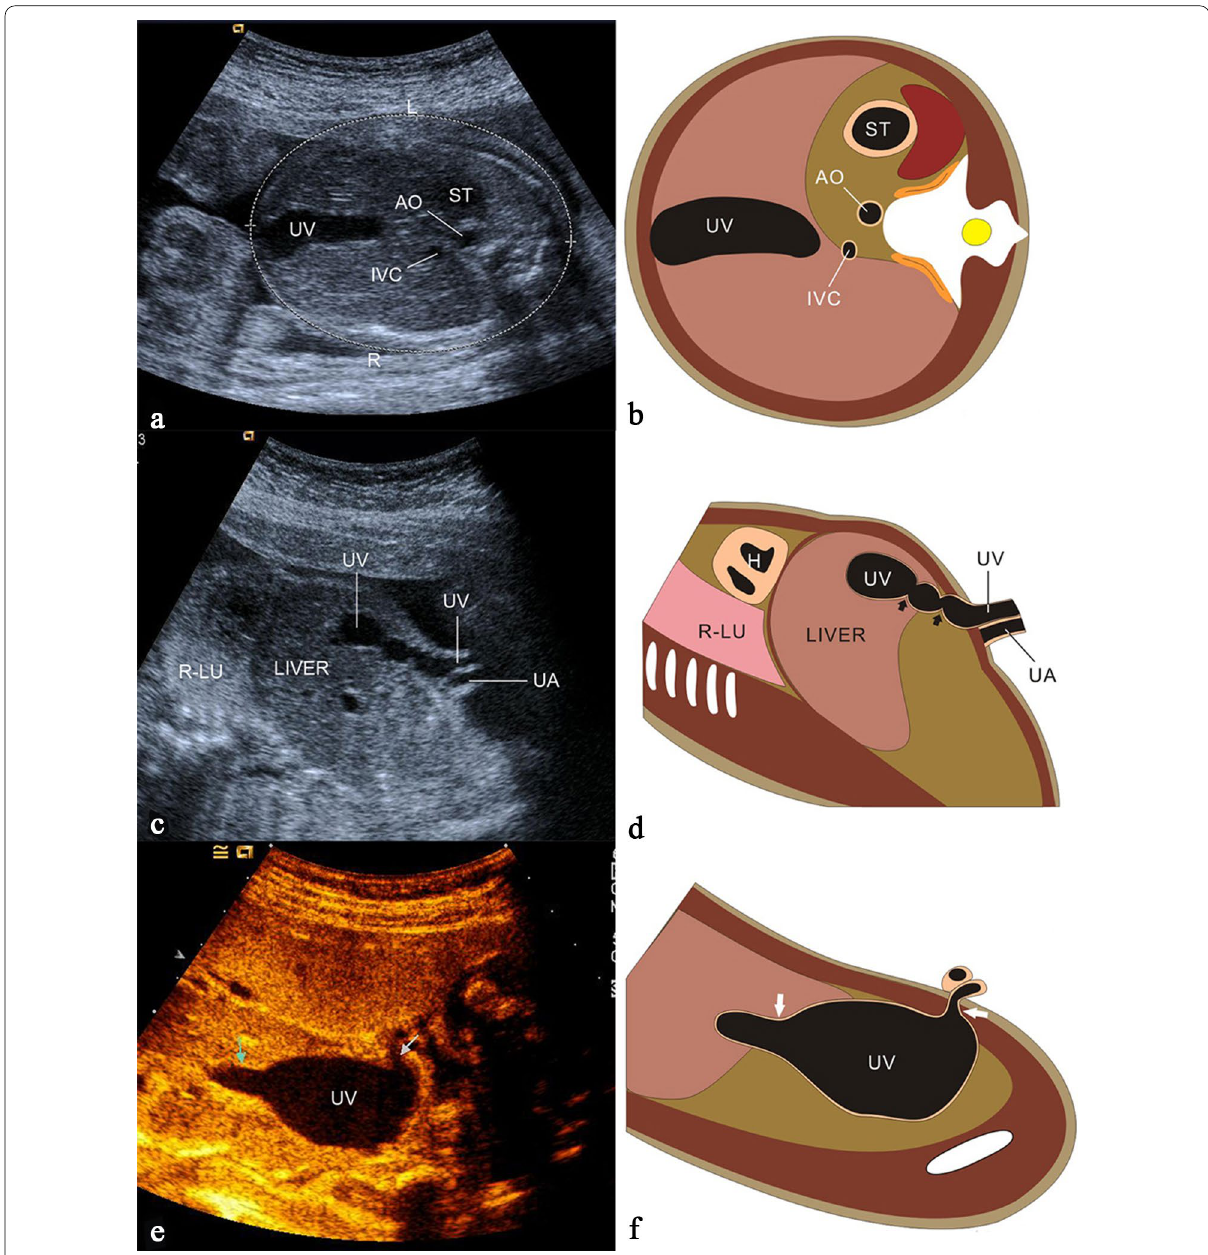
Fig. 10 Grayscale ultrasound image and scheme of the fetus showing different types of UVV. Images a , b illustrate the whole course dilation of UV. Images c and d show the multiple limited UVV. Images e and f show UVV like the